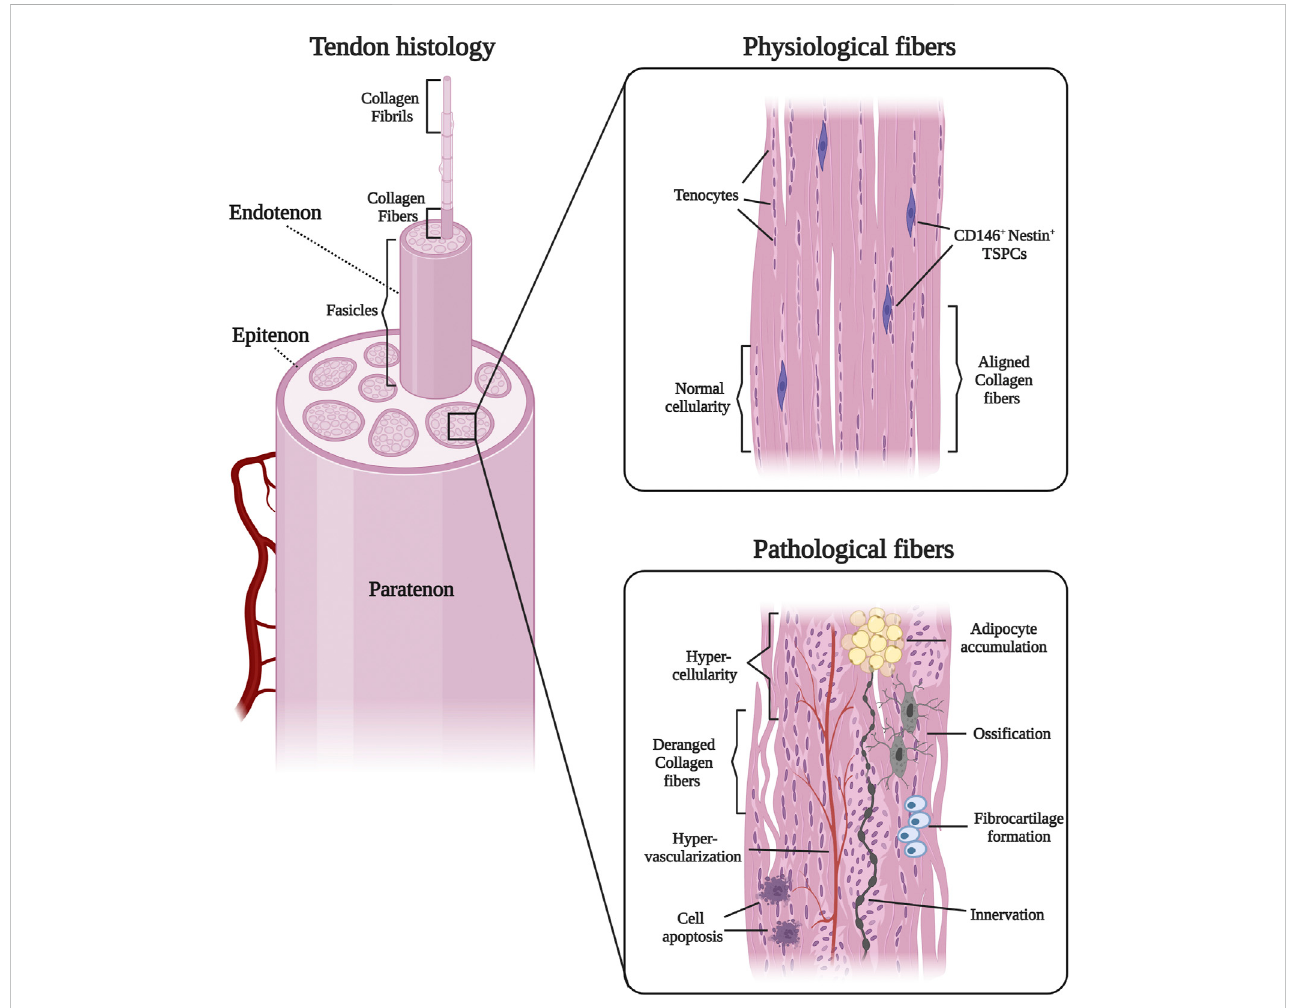
General tendon histology, and features of physiological and pathological